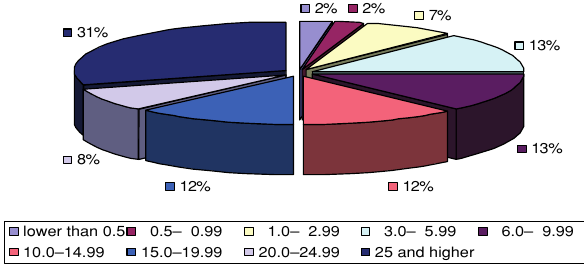
Source: Own figure based on CSO data Figure 7: Distribution of sour cherry orchards in Northern Hungary F according to size